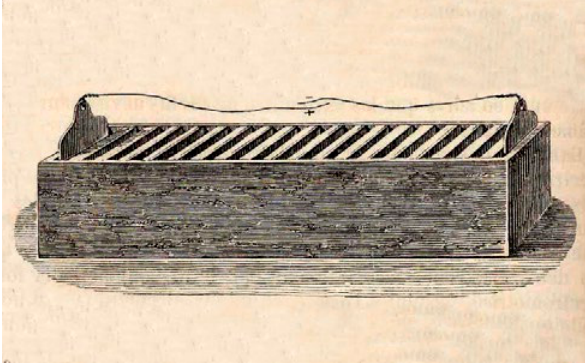
Figure 4. 19 th Century illustration of a trough battery (public domain).